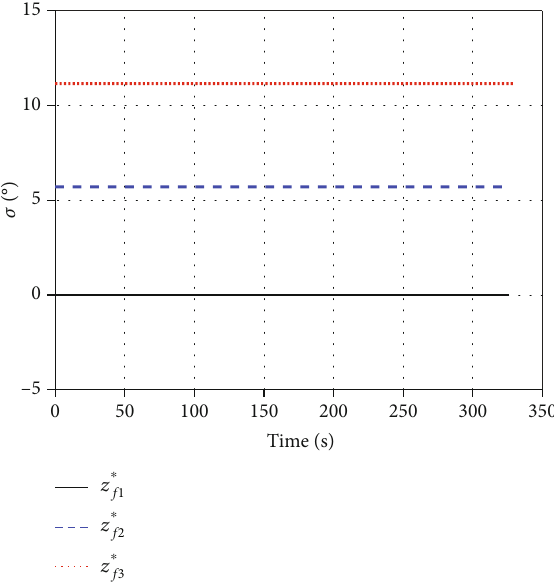
Figure 2: Three initial trajectory bank angles of di ff erent terminals.